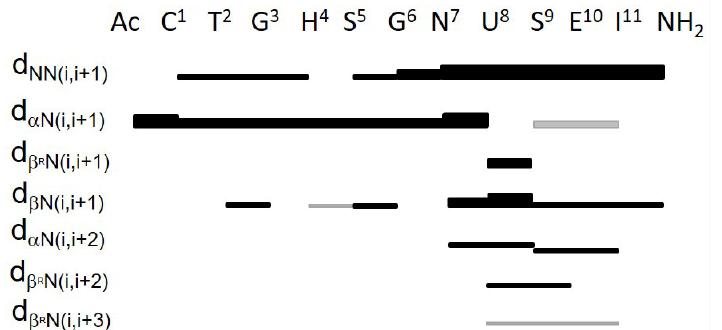
Figure 6. Summary of short- and medium-range NOE connectivities observed for Zn(II)-METP3 complex. The thickness of solid bars indicates the relative intensity of the NOEs, i.e., weak, medium and strong. Grey bars indicate spectral overlap.